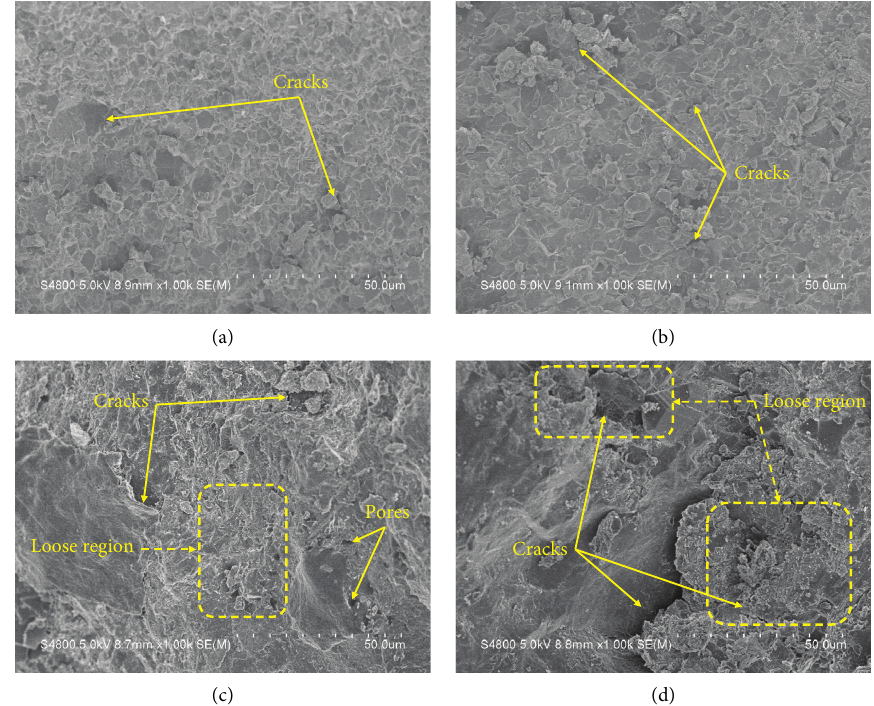
Figure 3: Microstructure of the OCC specimens after different freeze-thaw cycles: (a) 0 cycles; (b) 100 cycles; (c) 200 cycles; (d) 300 cycles.